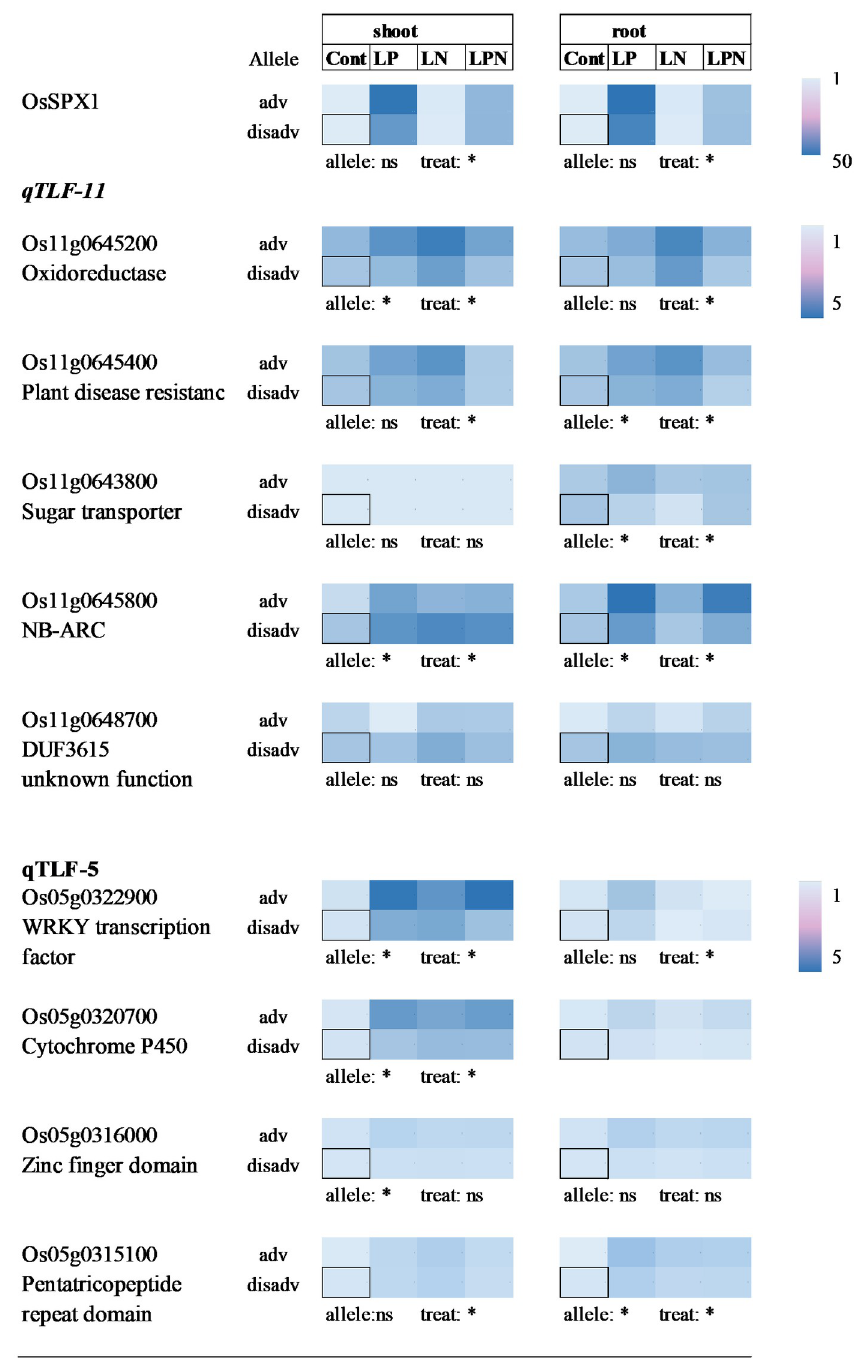
Fig 5. Relative expression pattern of potential candidate genes located within the total panicle weight (TPW) QTLs. Heatmap displays the differentially expressed candidate genes in root and shoot tissue from genotypes harboring advantageous/disadvantageous alleles, and under P, N, or both deficiency condition. Statistical significance was determined by two-way ANOVA and Tukey’s tests. Asterisks indicates significance levels ( ��� , �� , � , ns: p < 0.001, 0.01, 0.05, non-significant, respectively). Values were normalized to control treatment in accession with disadvantageous allele, in each tissue (square). adv: advantageous allele (G-38, G-355, G-1103), disadv: disadvantageous allele (X265, IR64, G-61,